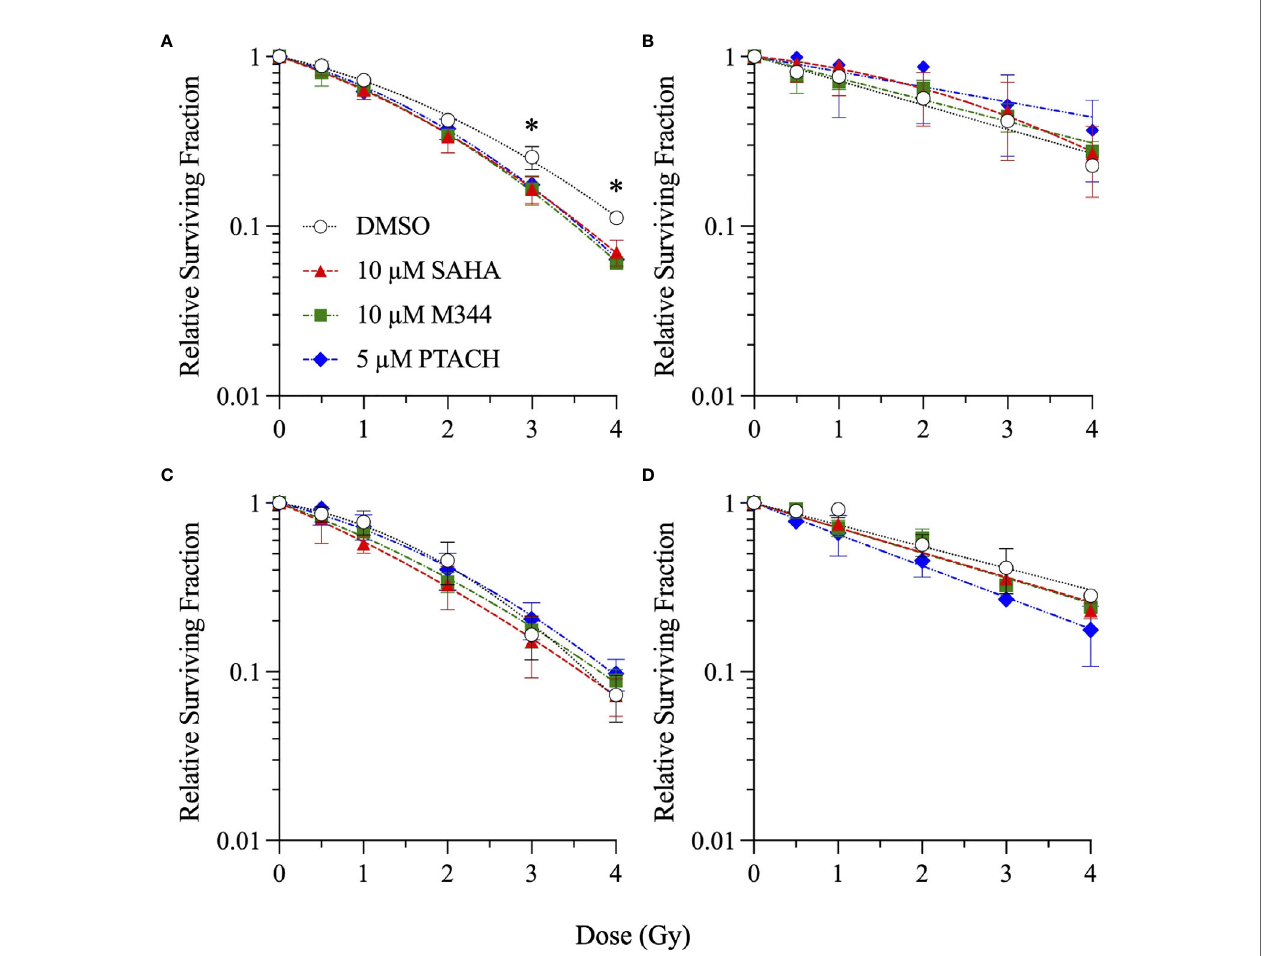
FIGURE 2 | Clonogenic survival of G0/G1-phase normal NFF28 primary fi broblasts (A) and asynchronously growing A549 lung carcinoma (B) , U2OS osteosarcoma (C) , and U87MG malignant glioma cells (D) pretreated for 18 h with 10 µM SAHA, 10 µM M344, or 5 µM PTACH and exposed to 0.5 – 4 Gy 200 MeV protons in the Bragg plateau region (LET = 0.45 keV/µm). Data reported as mean ± SD; where error bars are not visible, they are smaller than the data point. Asterisks mark signi fi cant differences compared to DMSO controls at p -values of ≤ 0.05 (*) by one-way